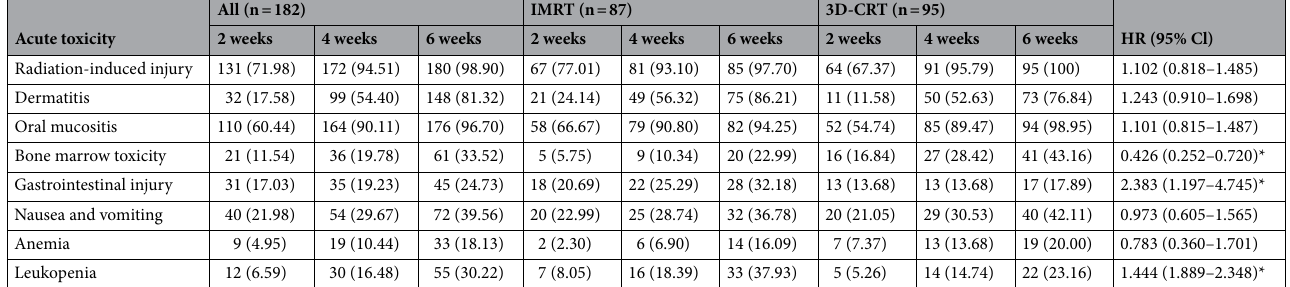
Table 3. Kaplan–Meier method compared for radiation-induced injuries between IMRT and 3D-CRT [N (%)]. IMRT intensity modulated radiation therapy, 3D-CRT three-dimensional conventional radiotherapy. Hazard ratios (HR) were calculated with the Cox proportional hazards model, P values were calculated with the log-rank test, *means P < 0.05.